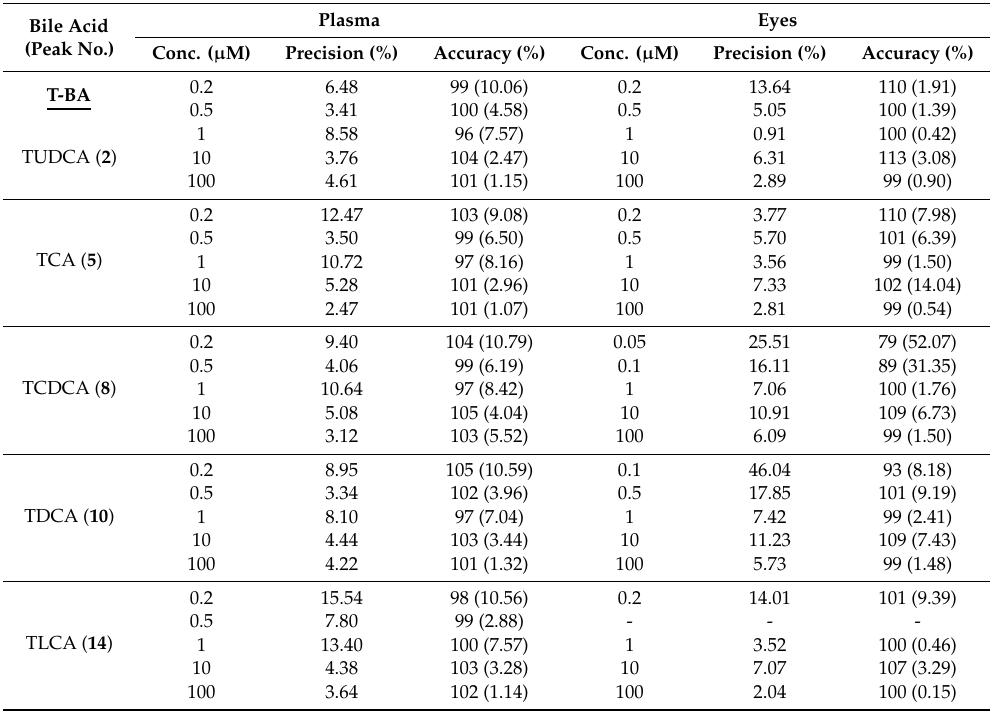
Table 2. HPLC method validation results of taurine-conjugated bile acids (T-BA) in mice plasma and eyes ( n = 3) 1